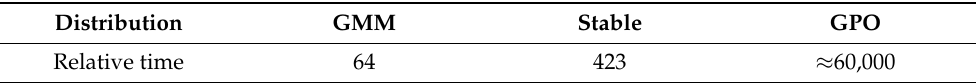
Table 8. Average computational time to calculate the VPLs with different overbounding methods. The times are the relative times compared with that of the Gaussian overbound. A lower time indicates less computational